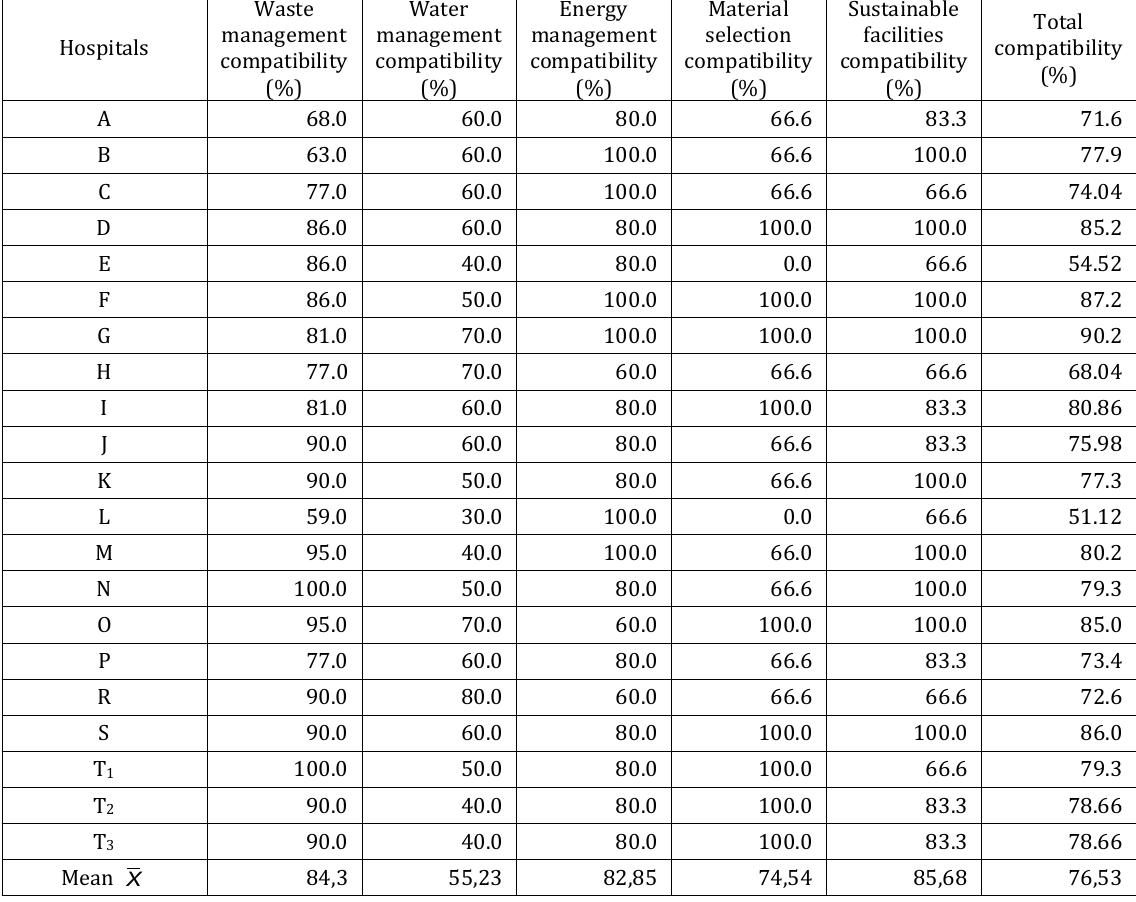
Table 6. Compatibility percentages of hospitals according to green